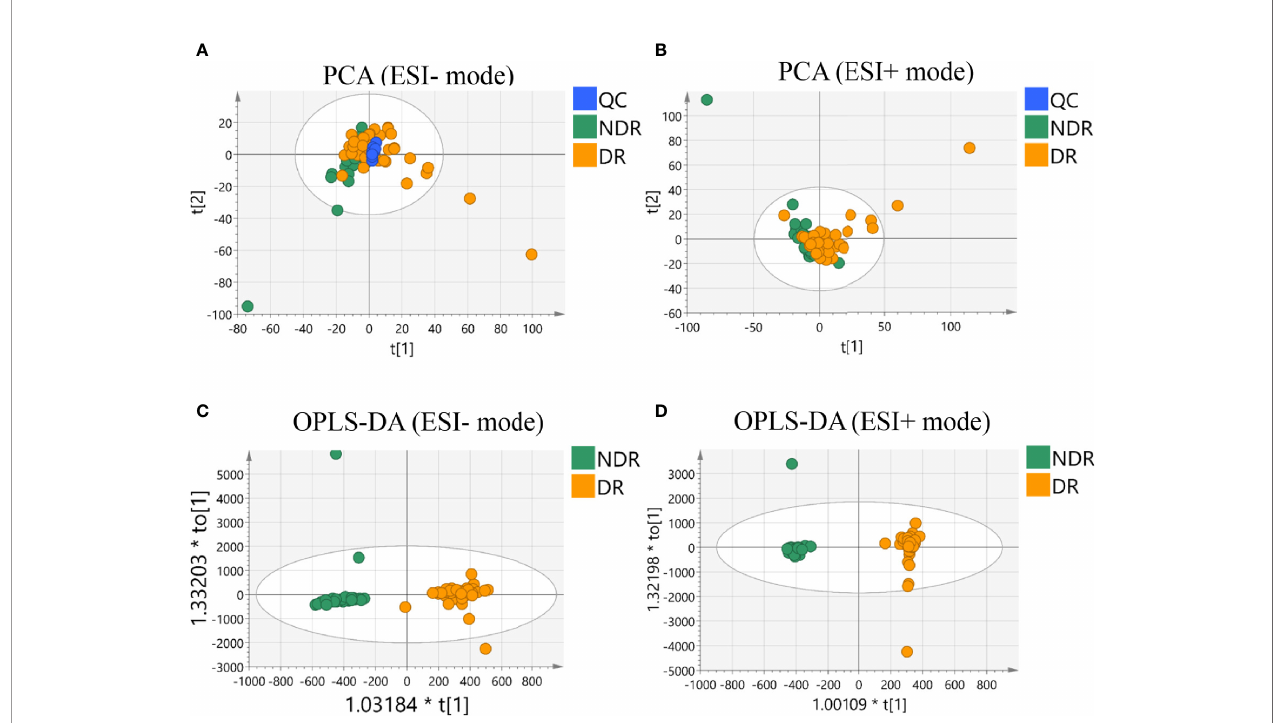
FIGURE 2 | Multivariate statistical analysis results. PCA score plot of the analysis in ESI ( – ) mode (A) and ESI (+) mode (B) . OPLS-DA score plot of the analysis in ESI ( – ) mode (C) and ESI (+) mode (D)